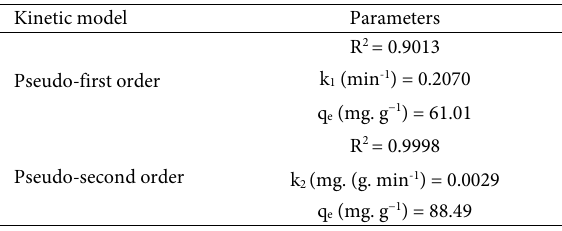
O /C Nanocomposite 3 4